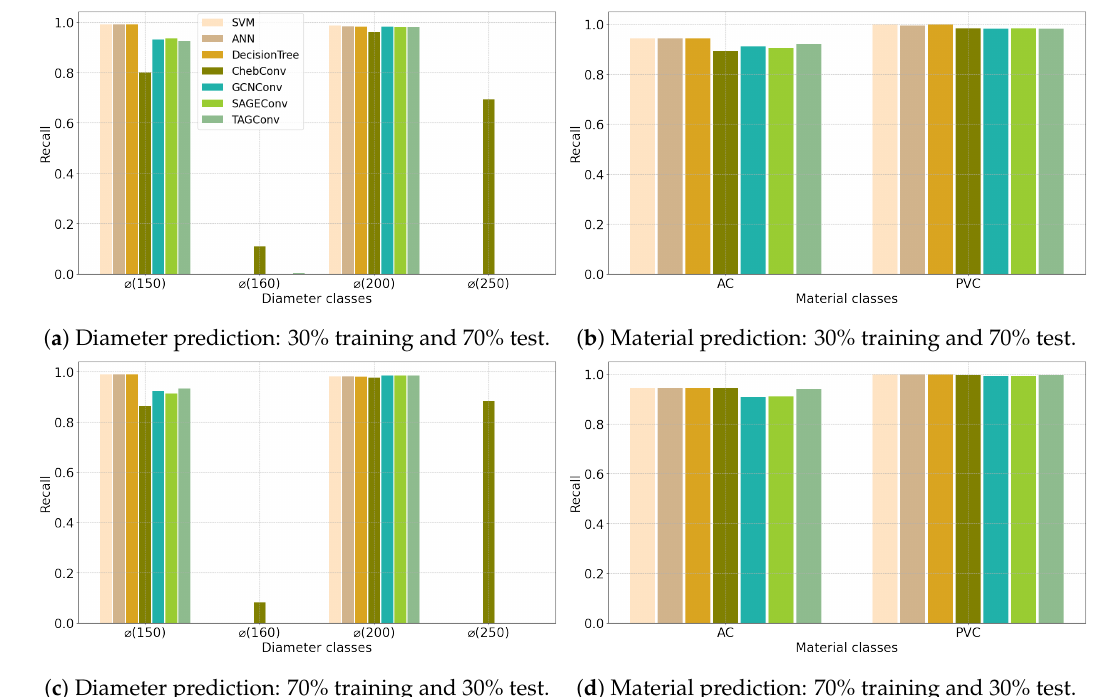
Figure 7. Configuration 2: Diameter and Material prediction for the Angers dataset for each class of the two attributes, evaluated using Recall score.